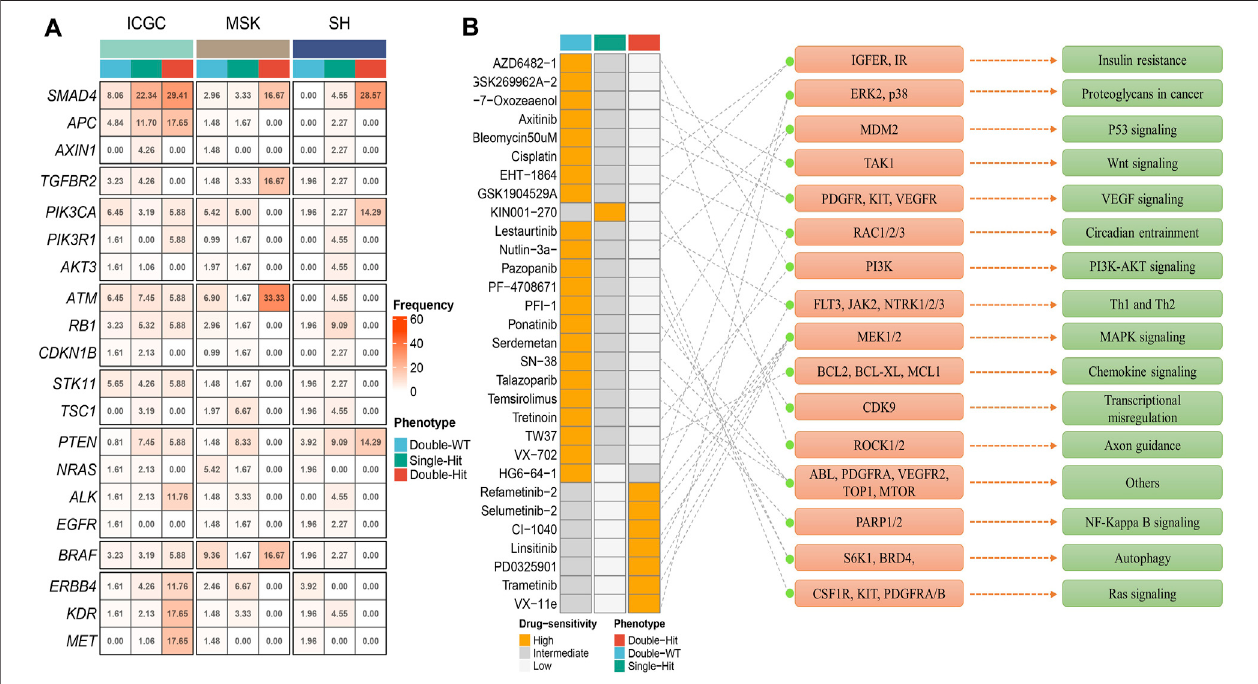
Frontiers in Genetics |